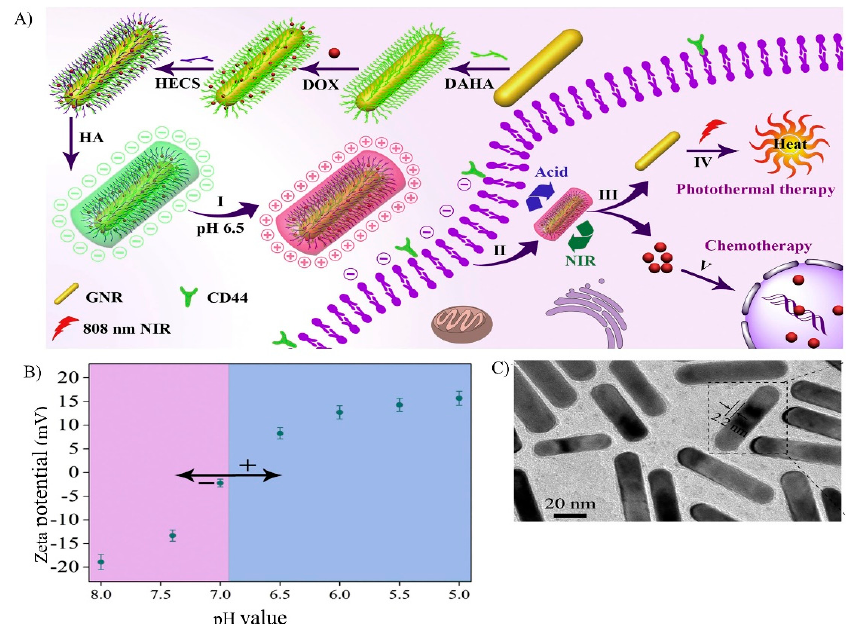
Figure 6. ( A ) Preparation of hydroxyethyl chitosan derivative (HECS) and hyaluronic acid (HA) coated gold nanorods functionalized with aldehyde/catechol- hyaluronic acid (DAHA) and loaded with DOX (gold nanorod-DAHA DOX -HECS-HA), as a charge reversal, pH/NIR responsive therapeutic agent. ( B ) The charge-reversible nature of gold nanorod-DAHA DOX -HECS-HA was analyzed by measuring the zeta potentials at different pH values. When the pH of the media was reduced from 8.0 to 5.0, the zeta potential increased from − 18.9 to 15.7 mV, indicating charge reversal. ( C ) TEM image of gold nanorod-DAHA DOX -HECS-HA showing the shell thickness of 2.2 nm. Reproduced with permission from Reference [128] Copyright © 2019